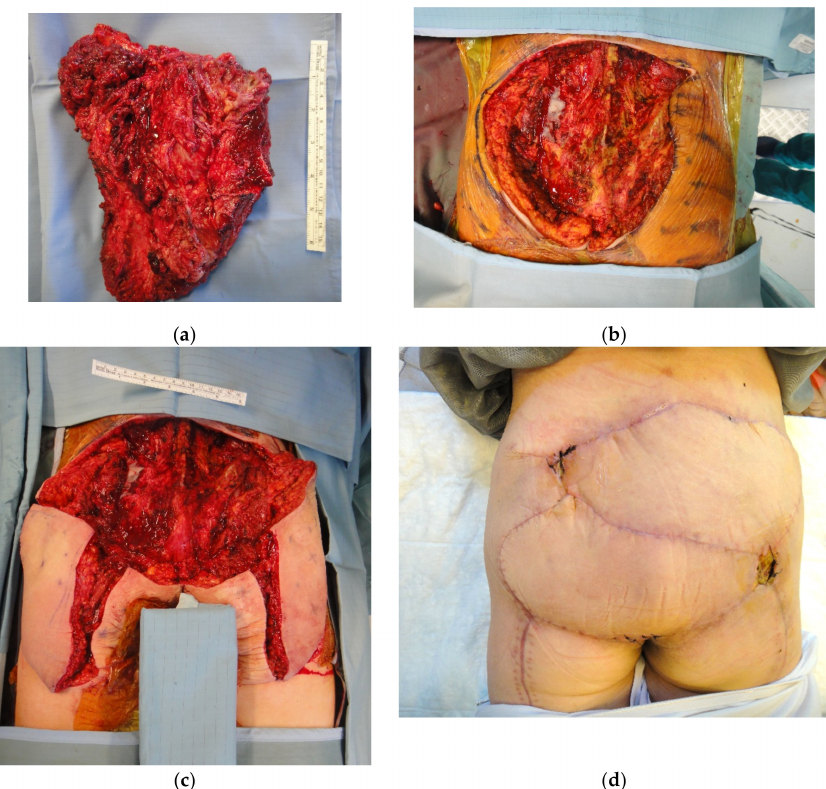
Figure 8. ( a ) Specimen of fibrosarcoma after wide margin excision; ( b ) the residual defect—22 × 16 cm; ( c ) 2 propeller flaps elevated on the perforator of the superior gluteal artery bilaterally; and ( d ) result at 2 months FU (Follow‑up).